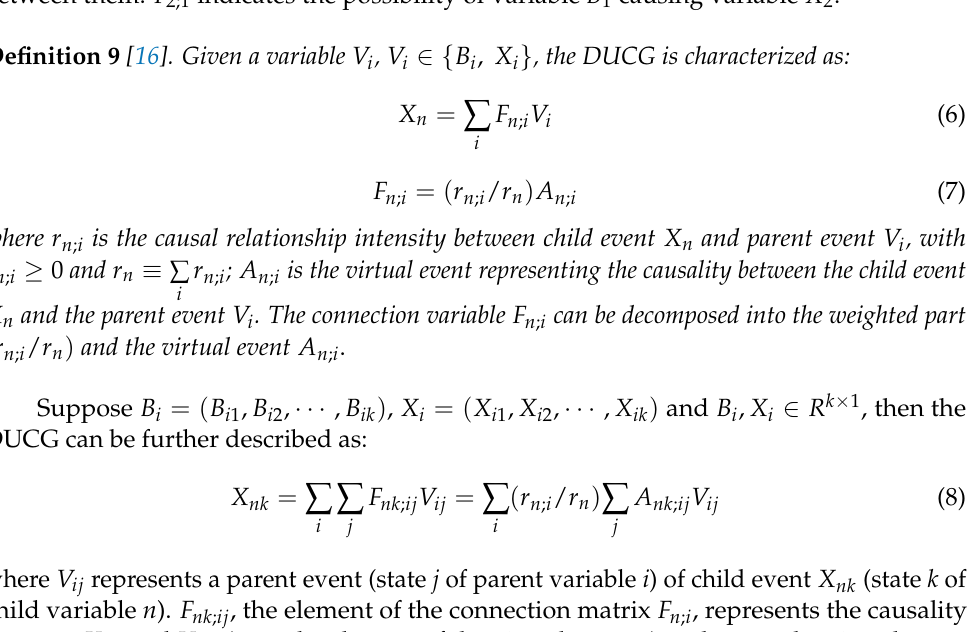
indicates the possibility of variable B 1 causing variable X 2 .